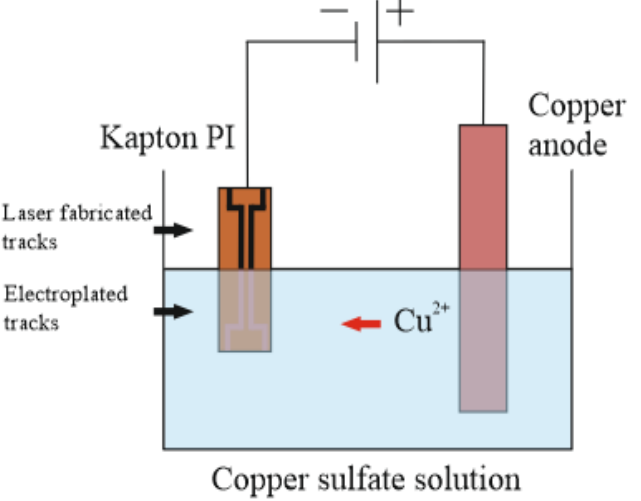
Figure 2. Electroplating scheme.